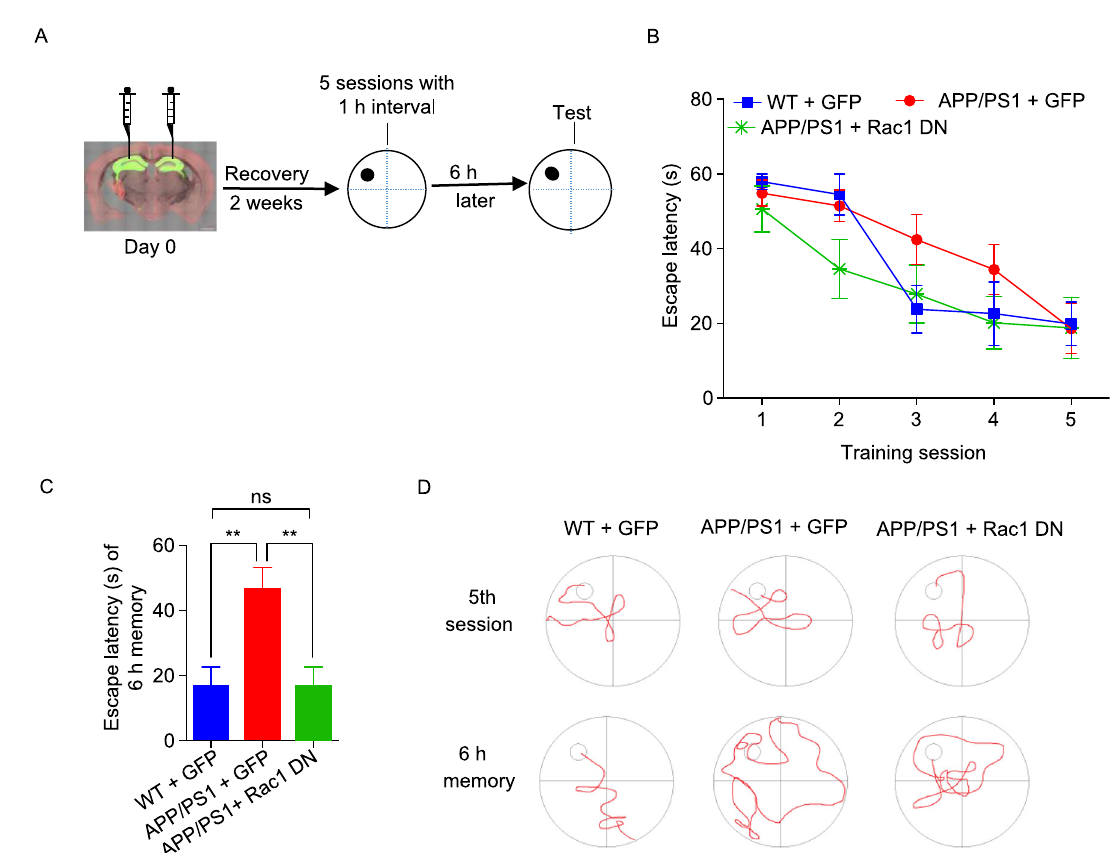
Figure 3. Accelerated spatial memory loss in young (3-month-old) APP/PS1 mice could be halted by expression of Rac1